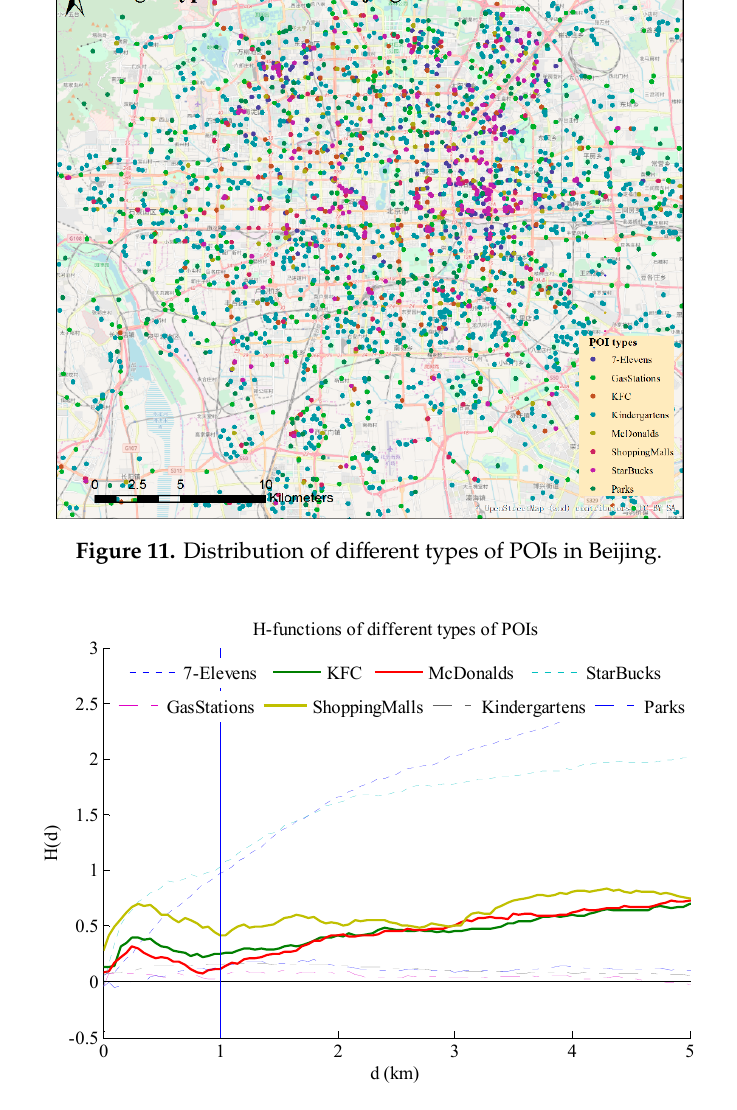
Figure 12. H-functions of different types of POIs. The aggregative clustering patterns shown are for 7-Elevens and Starbucks. The repulsive clustering patterns shown are for KFC, McDonalds, and shopping malls. Table 2. Distribution pattern for different types of POIs.